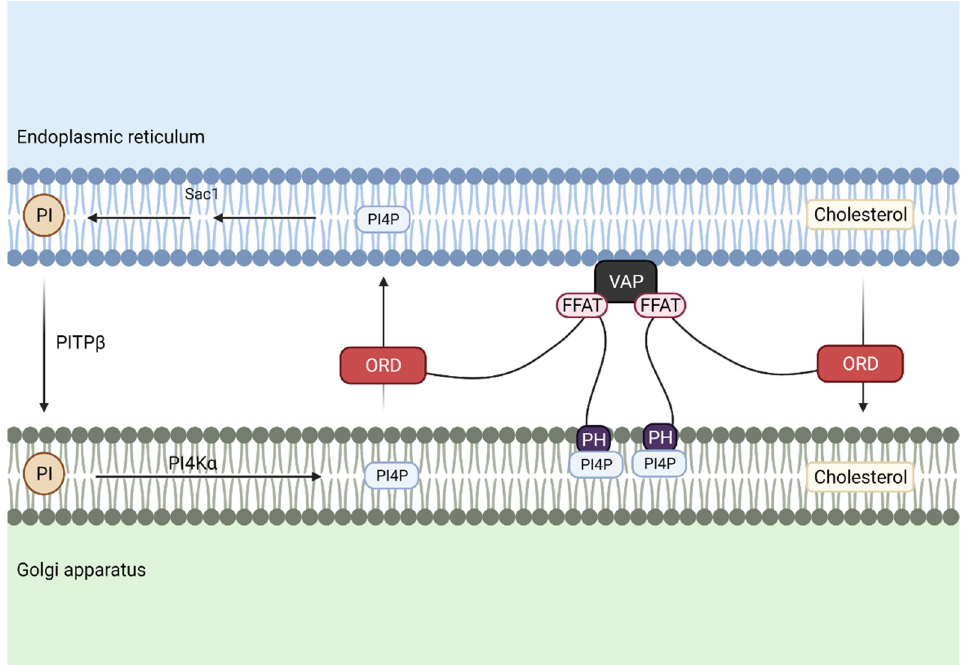
Figure 5. Cholesterol and phosphatidylinositol 4 ‐ phosphate (PI4P) are transported between the en ‐ doplasmic reticulum (ER) and the Golgi apparatus. To maintain PI4P levels associated with cholesterol transport, phosphatidylinositol (PI) is transferred through phosphatidylinositol transport protein β (PITP β ), while the OxySterol Binding Protein (OSBP)-Related Domain (ORD motif) of Oxysterol Binding Protein (OSBP) transports cholesterol from the ER to the Golgi membrane and reciprocal transport of PI4P from Golgi membrane to the ER. Association of these two membrane structures is achieved by the interaction of the two phenylalanines (FF) in an acidic tract (FFAT)-like motif of OSBP with vesicle-associated membrane protein-associated protein (VAP) in the ER, and pleckstrin homology domain (PH domain) from OSBP, which binds to PI4P at the Golgi.